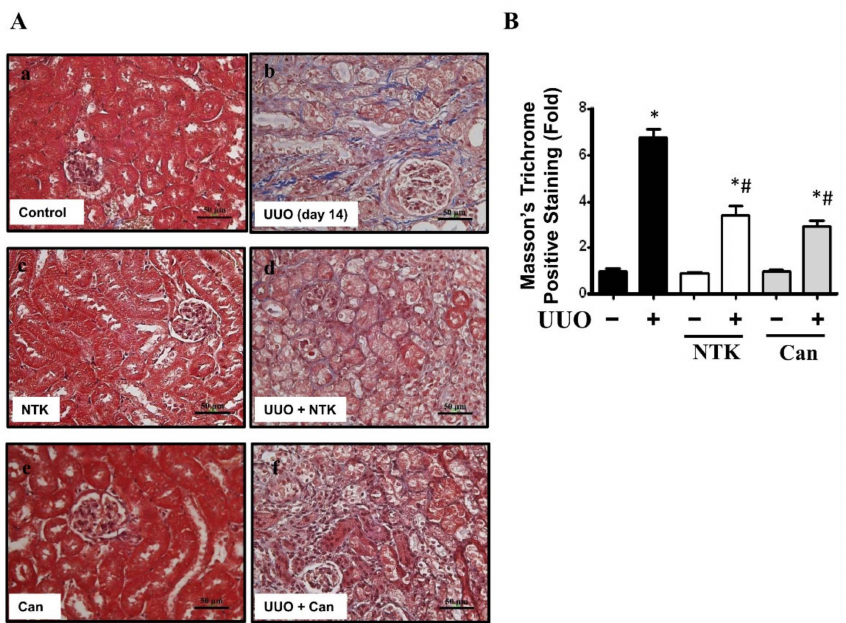
Figure 2. Effects of Nootkatone treatment on the collagen deposition in the kidneys of UUO mice. Vehicle, Nootkatone (NKT), or candesartan (Can; positive control) was orally given to the sham or UUO mice for 14 days. Collagen deposition was determined by Masson’s Trichrome staining ( A ). a, Control; b, UUO; c, NTK; d, UUO+NTK; e, Can; f, UUO+Can. Scale bar: 50 µ m. The quantification is shown in ( B ). Data are presented as mean ± SD ( n = 6). * p < 0.05 vs. the sham control group. # p < 0.05 vs. the UUO group.